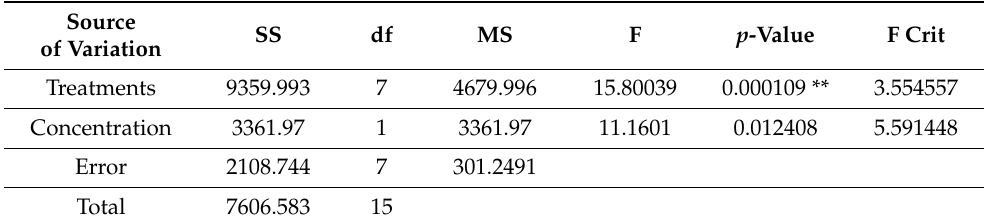
Table 4. Analysis of variance (ANOVA) for eight concentrations of NP with cytotoxicity and cell proliferation.